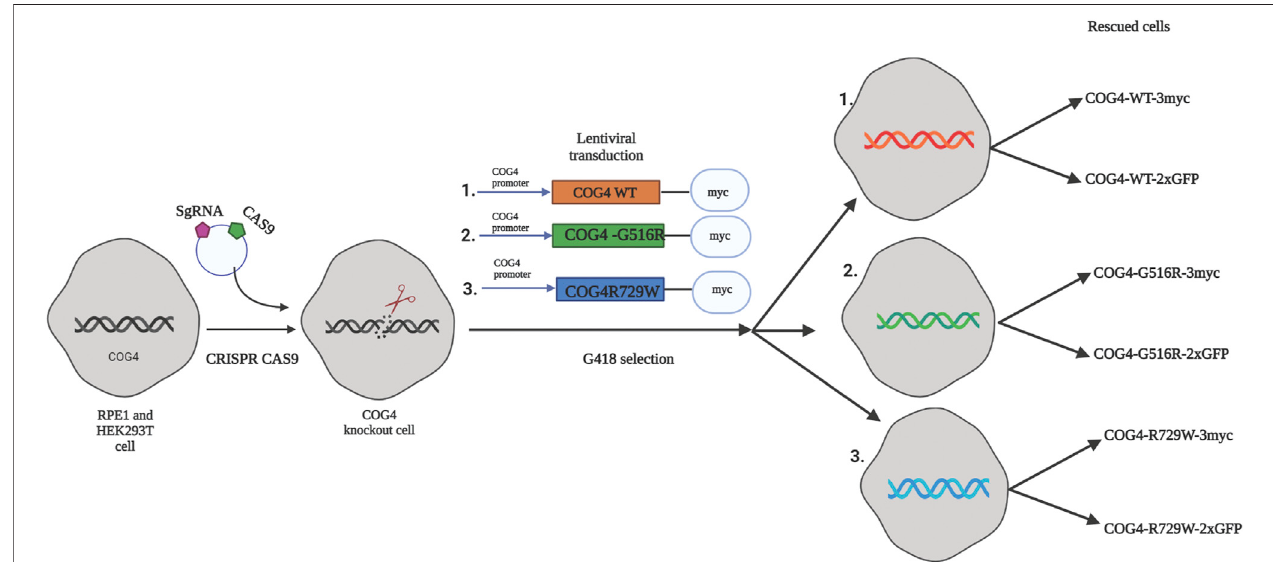
FIGURE 1 | The strategy for the creation of cellular COG-CDG models. A conceptual design of the COG4-SWS and COG4-CDGIIj cellular models. In the fi rst step CRISPR/Cas9 protocol was used to make RPE1 and HEK293T COG4 KO cells lines. On the second step, lentiviral transduction and G418 selection was utilized to create populations of isogenic cells expressing GFP or 3myc-tagged COG4 variants under endogenous COG4